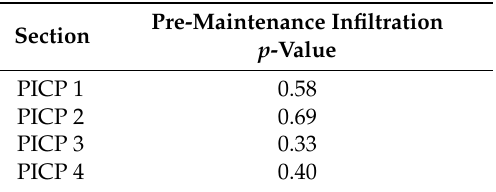
Table 5. Overall significance of difference for two-sided generalized Wilcoxon test during Pre-Maintenance.